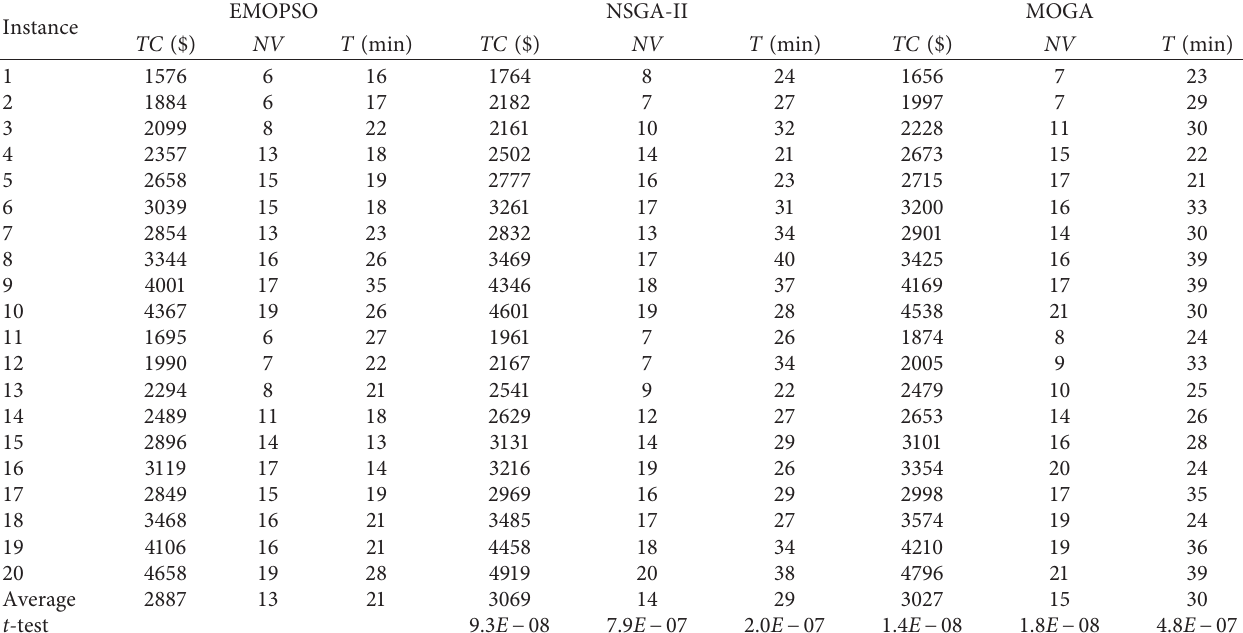
Table 10: Optimization result comparison by each